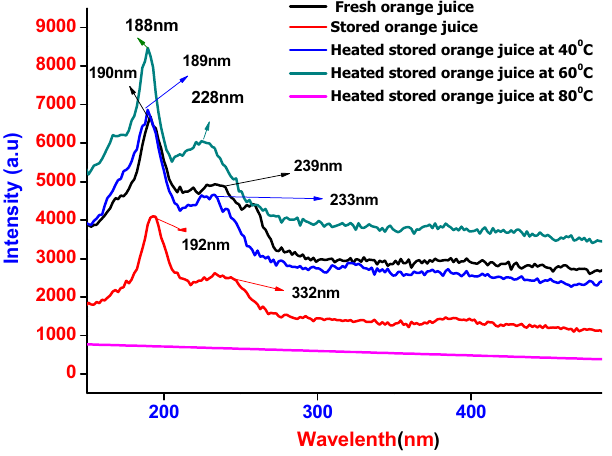
Figure 5. Fluorescence spectral emission of Orange juices.